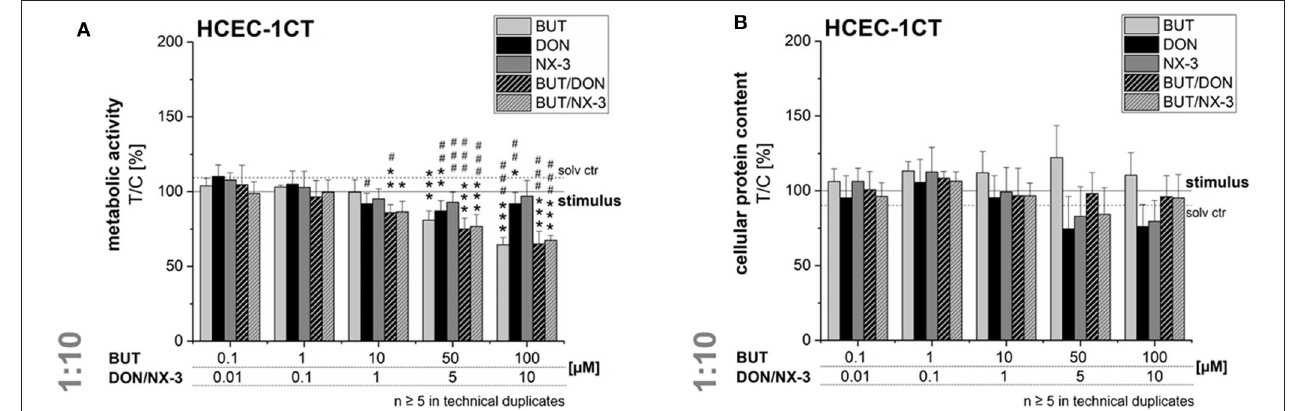
FIGURE 6 | Effects on cell viability of HCEC-1CT cells after 2h pre-incubation with BUT (10 µ M), DON (1 µ M), NX-3 (1 µ M) and respective 10:1 combinations, followed by 3h co-stimulation with IL-1 β (25ng/mL) in the alamarBlue ® (A) and the SRB-assay (B) . Cell viability data are normalized to the stimulated solvent control levels (solid line, dotted line: solvent control without pro-inflammatory stimulus). Data are expressed as mean values ± SD of at least five independent experiments performed in technical duplicates. Significant differences to the stimulated solvent control are indicated with * p < 0.05, ** p < 0.01, and *** p < 0.001, whereas significant differences between concentrations of the same compound with the respective lowest tested concentration, calculated by one-way ANOVA, followed by Bonferroni’s post-hoc tests are indicated with # p < 0.05, ## p < 0.01, and ### p <